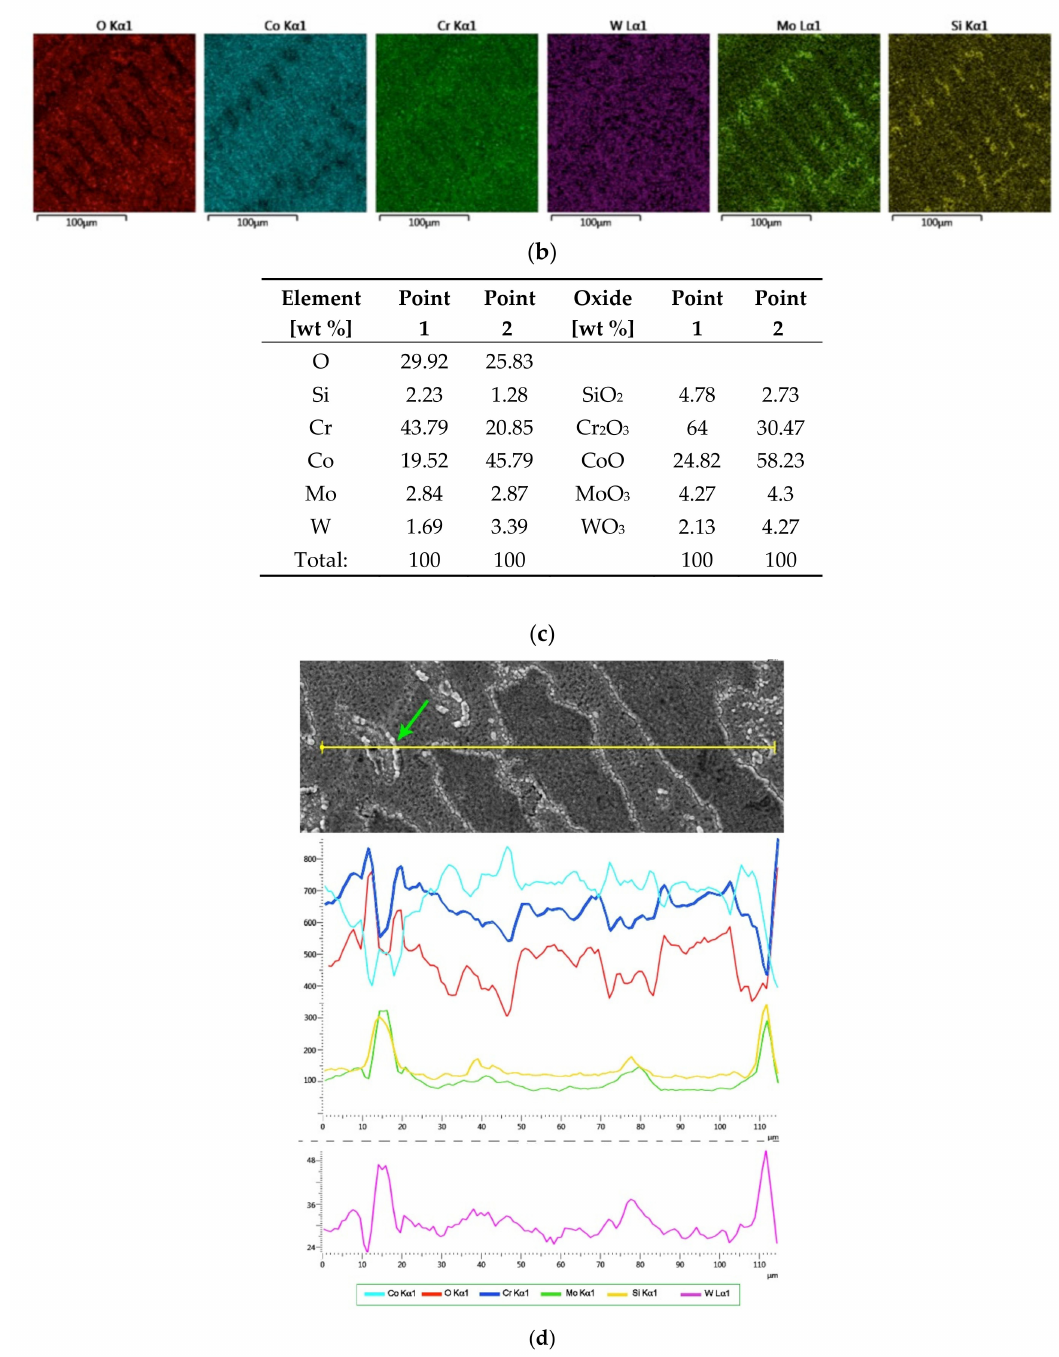
Figure 4. SEM EDS results for the CST2 sample: ( a ) SEM-SE micrograph showing the morphology with average EDS results from the marked area; ( b ) maps presenting the surface distribution of O, Co, Cr, W, Mo, and Si; ( c ) EDS results for marked points; ( d ) SEM-SE micrograph with corresponding EDS line scan